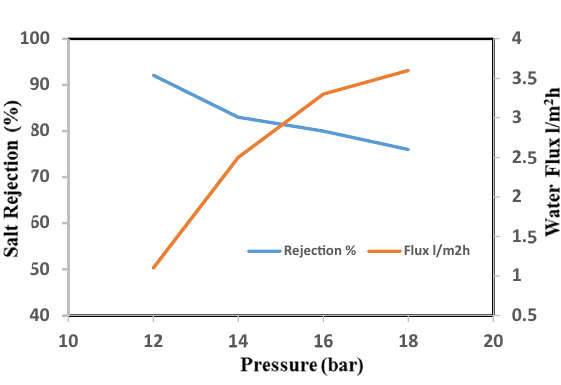
Figure 9. Salt rejection and water flux versus feed pressure of pristine CA-RO